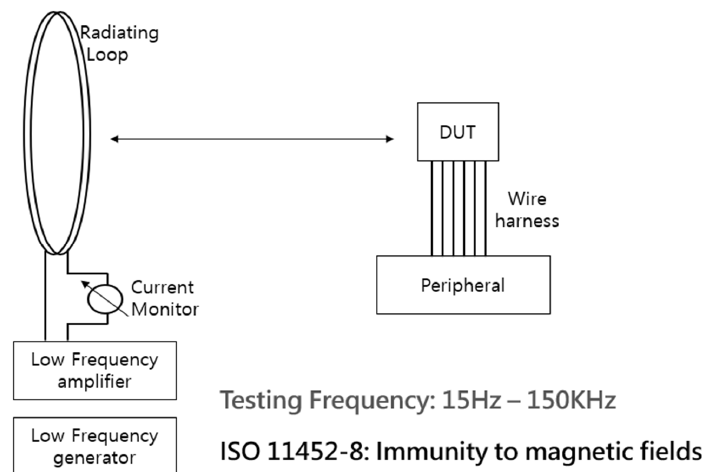
Figure 12. Schematic drawing of ISO11452-8 magnetic immunity test at 15 Hz and 1 kA/m. DUT: device under